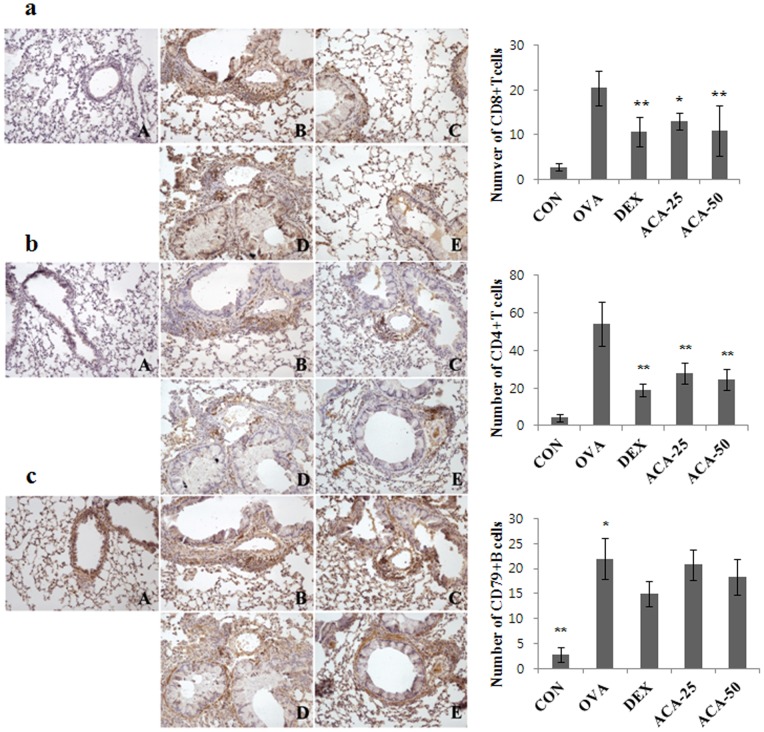
ACA suppressed T cells but not B cells in mice with OVA-induced asthma.(a) ACA dose-dependently suppressed the upregulation of CD8+ cytotoxic T cells in the lungs. (b) ACA suppressed the upregulation of CD4+ Th cells as effectively as dexamethasone. (c) ACA did not affect CD79α+ B cells in the lungs of mice with OVA-induced asthma. Immunopositive cells were counted in five randomly selected nonoverlapping fields (×200 magnification) of three separately immunostained lung sections per animal. A, vehicle control; B, OVA-induced asthma model; C, dexamethasone; D, 25 mg/kg/day ACA; E 50 mg/kg/day ACA.